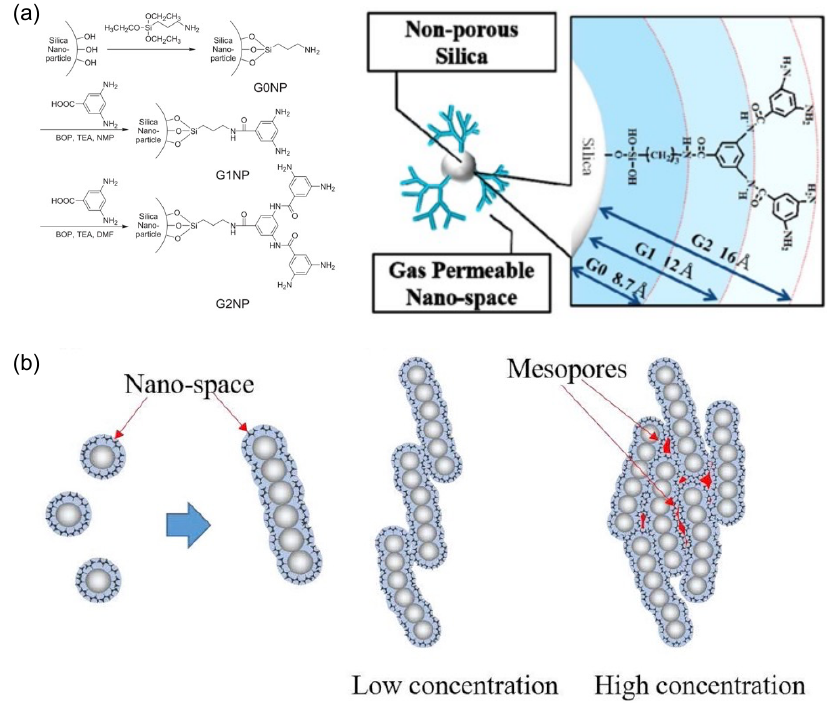
Figure 11. ( a ) Surface modification of silica nanoparticles to generate dendritic amino nanospace. Reprinted with permission from [58], copyright 2017 Elsevier. ( b ) Change from spherical particles to pearl necklace particles for the formation of efficient gas transport channels via the assembly of surface-modified and structure-specific nanoparticles at high concentrations. Reprinted with permission from [177], copyright 2020 Elsevier.